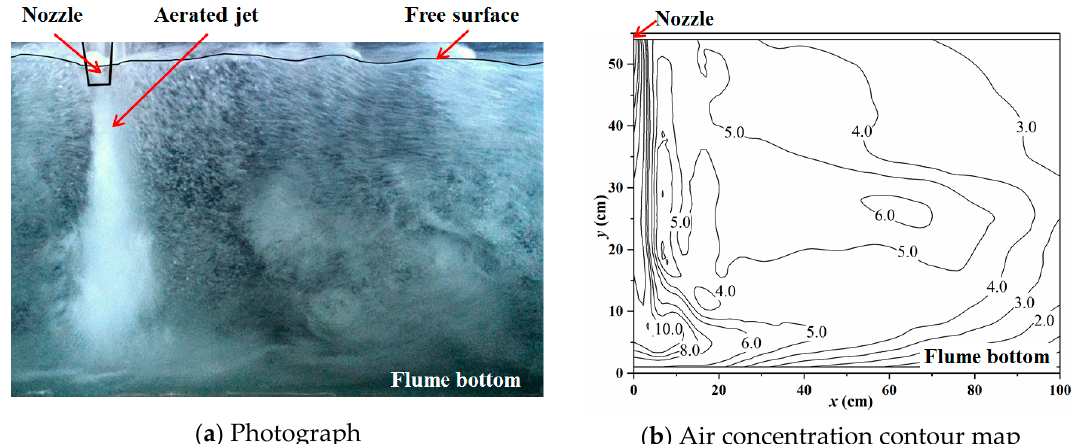
Figure 3. Air concentration distribution for d 0 = 2 cm, C 0 = 30%, Q w = 16.8 L/s.